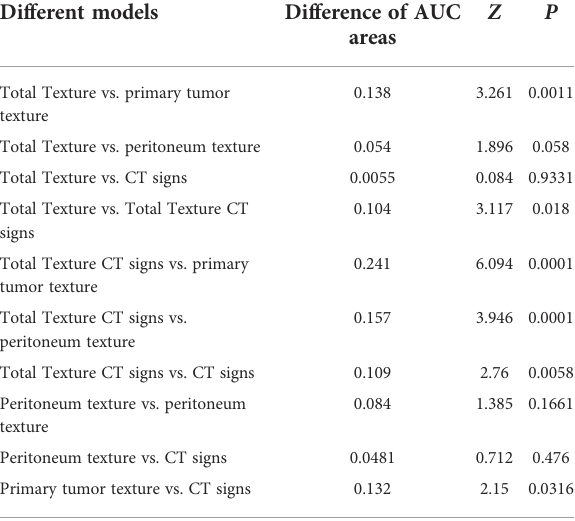
TABLE 5 Comparison of ROC curves AUC areas of different models.